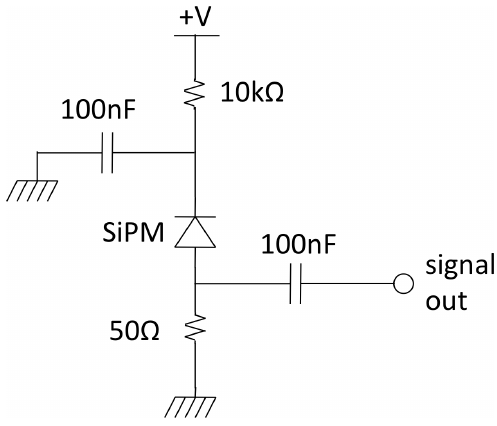
Figure 2. The polarization network and readout circuit of each SiPM, replicated on the electronic board for the 100 elements of the array.